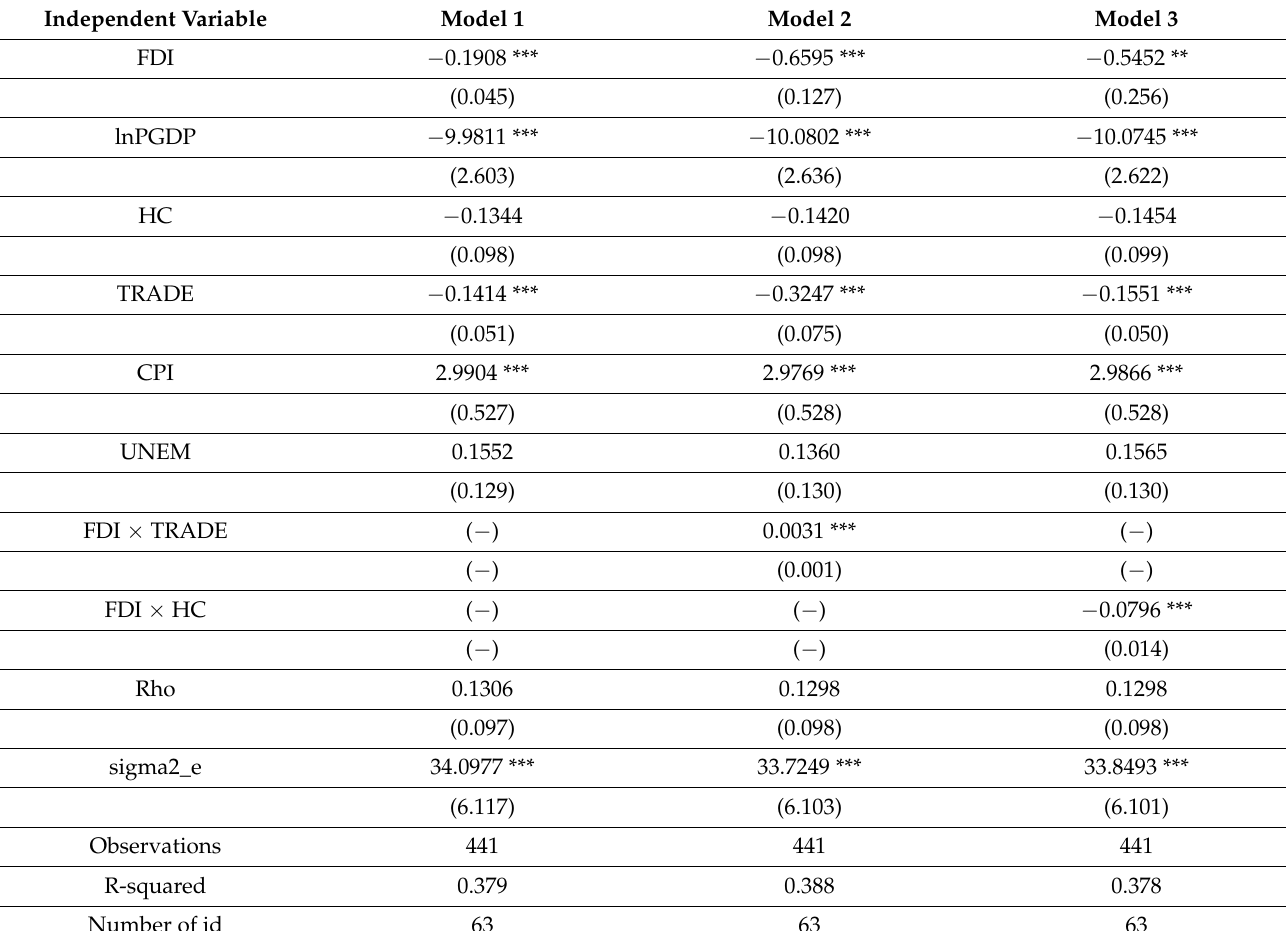
Table 4. Spatial Durbin Model with time fixed-effects regression